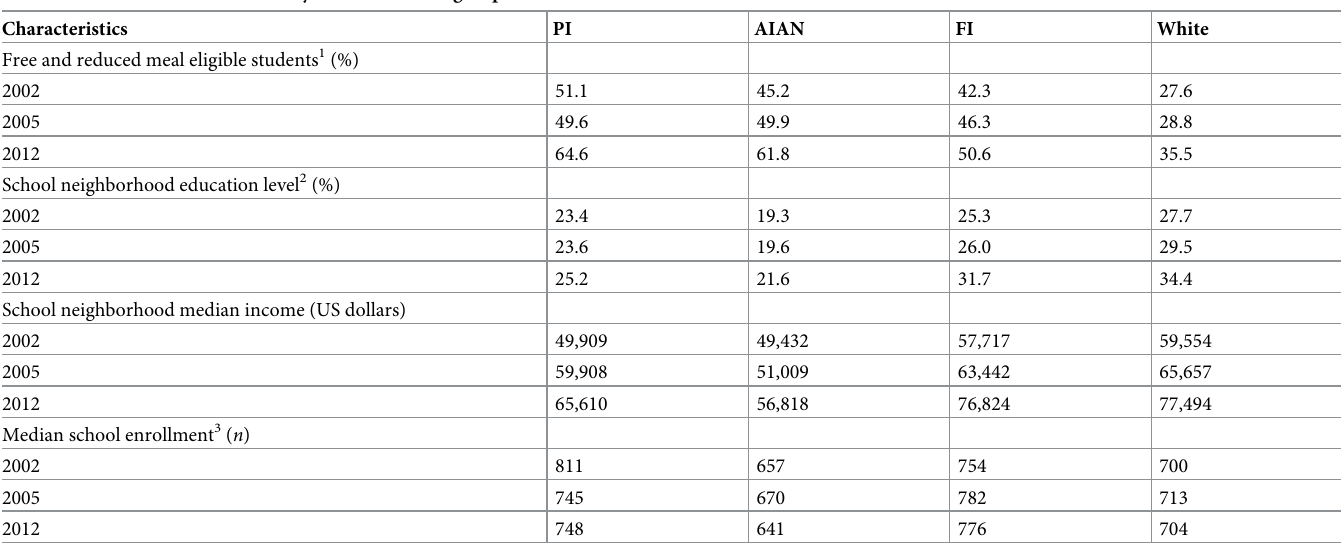
Table 2. Characteristics of schools by racial/ethnic